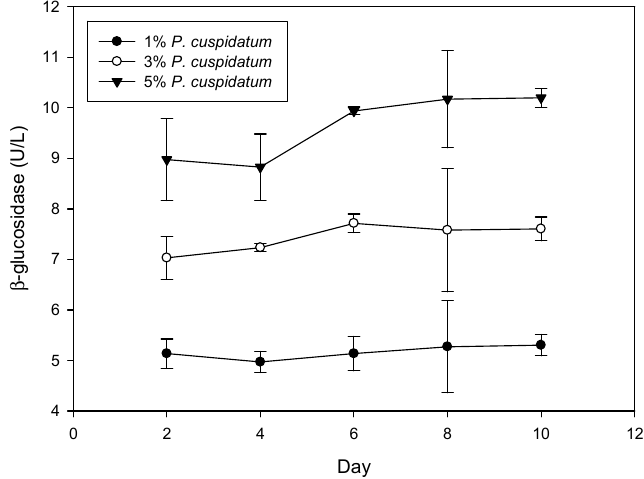
Figure 4. Effect of P. cuspidatum roots on the β -glucosidase activity during rice wine fermentation.